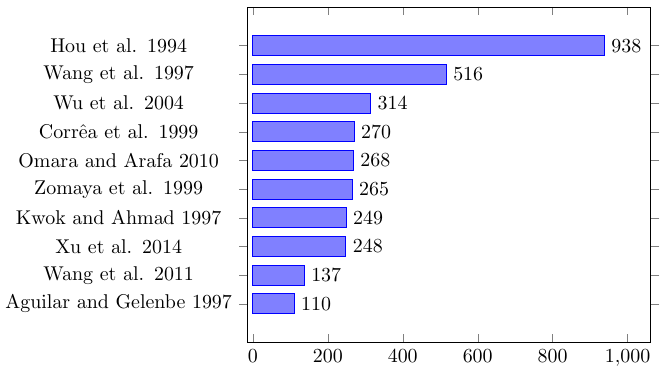
Figure 4. Most cited works according to the Google Citation